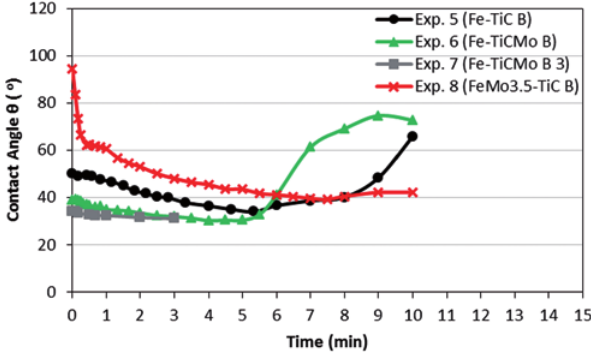
Fig. 2: Contact angles vs. time in type B experiments